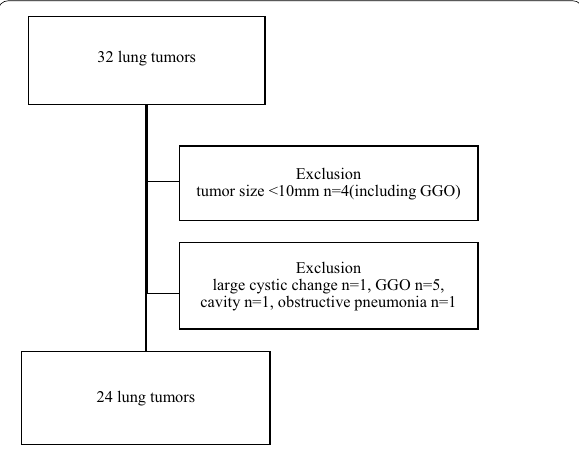
Fig. 3 Flowchart showing the patient selection